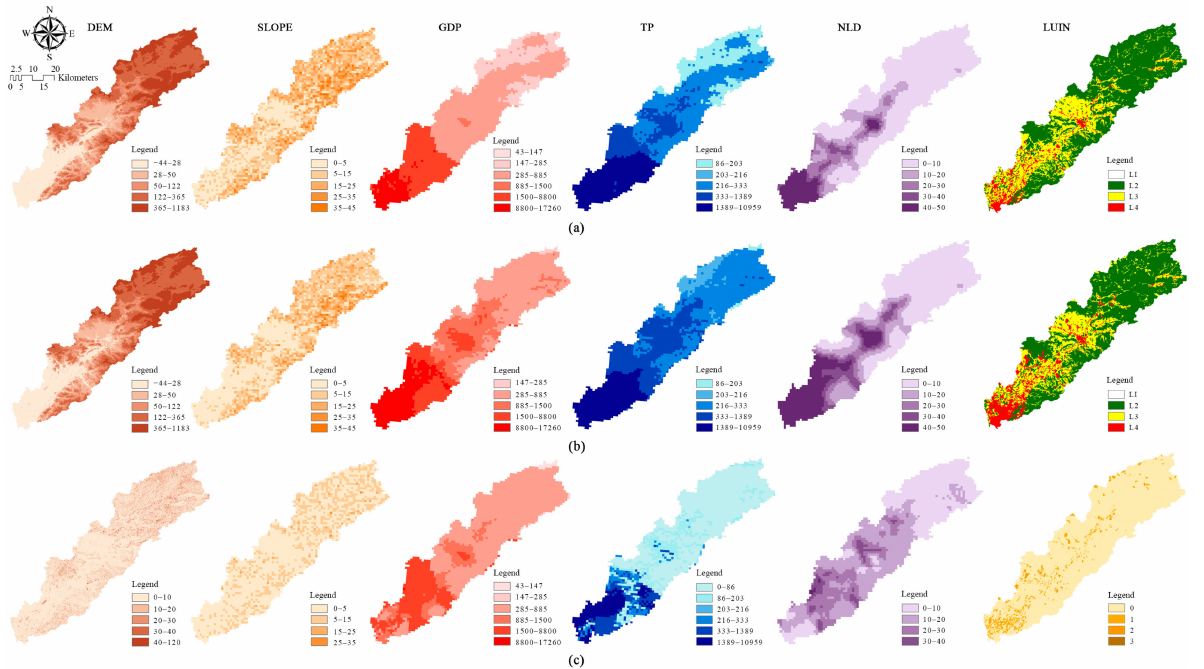
Figure 11. Spatial distributions of the selected influencing factors selected in this study in ( a ) 2000 and ( b ) 2010, and ( c ) shows the results of the subtraction of each influencing factor between 2000 and